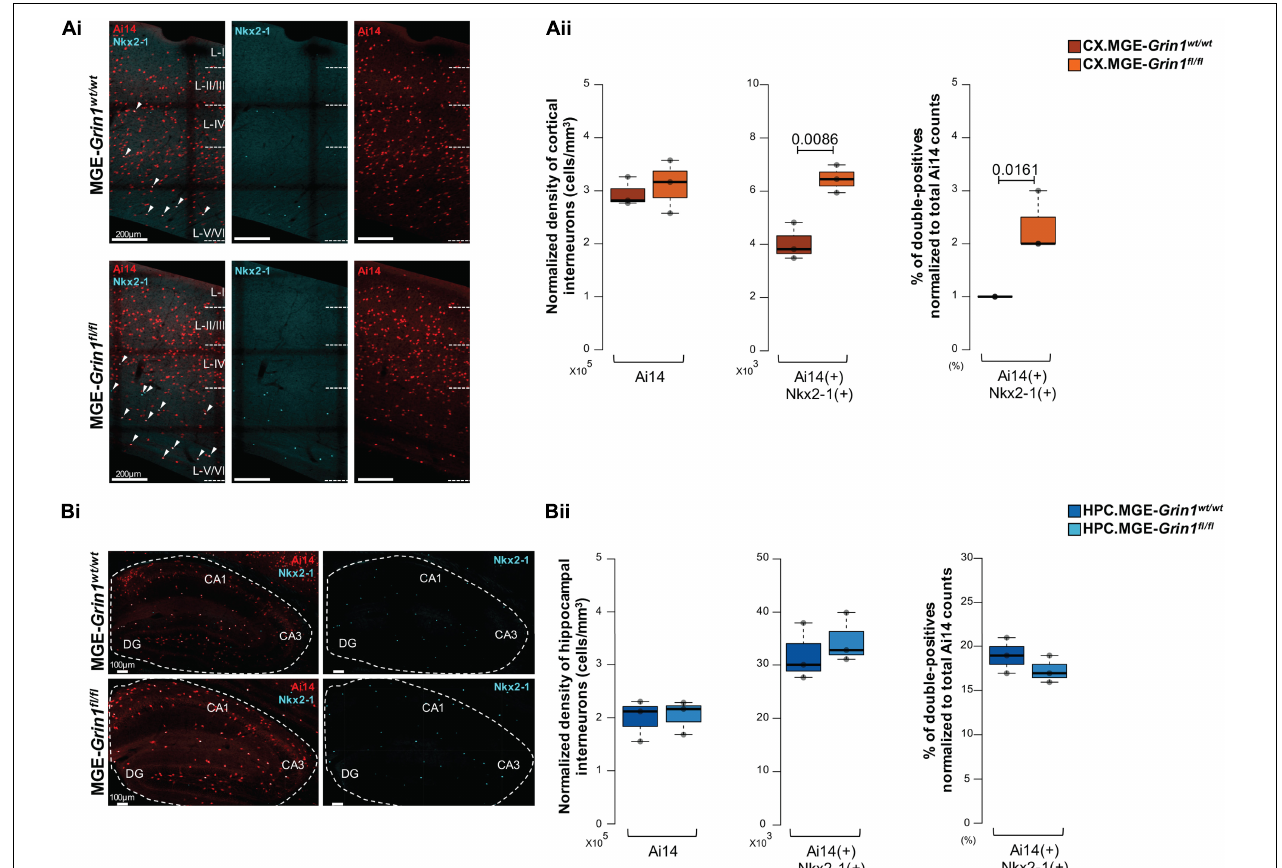
FIGURE 4 | Validation of Nkx2.1-expressing interneuron abundances subsequent to Grin1 -ablation by immunostaining. (Ai) , Representative immunostaining of P25-30 somatosensory cortex using anti-Nkx2-1 (cyan), and endogenous Ai14 reporter expression. (Aii) Boxplots indicate the normalized density of cortical Ai14(+) and Ai14(+): Nkx2-1(+) double-positive cell counts. (Bi) Representative immunostaining of P25-30 hippocampus using anti-Nkx2-1 (cyan), and endogenous Ai14 reporter expression (red). (Bii) Boxplots indicate the normalized density of hippocampal Ai14(+) and Ai14(+): Nkx2-1(+) double-positive cell counts. n = 3 brains (4 sections/brain) from each genotype for immunostaining; Error bars reflect SEM from individual sections; two-tailed unpaired t -test, for statistical analysis.